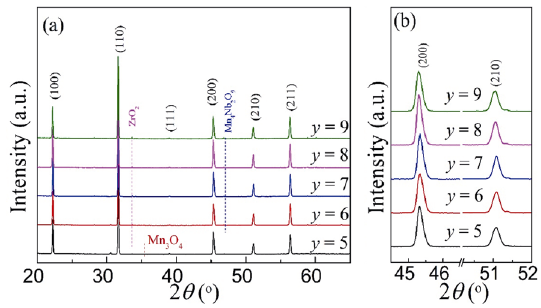
Fig. 2 XRD patterns of KNNT–0.055BZ + 0.03Zr + y Mn ceramics: (a) 2 θ = 20°–65° and (b) 2 θ =